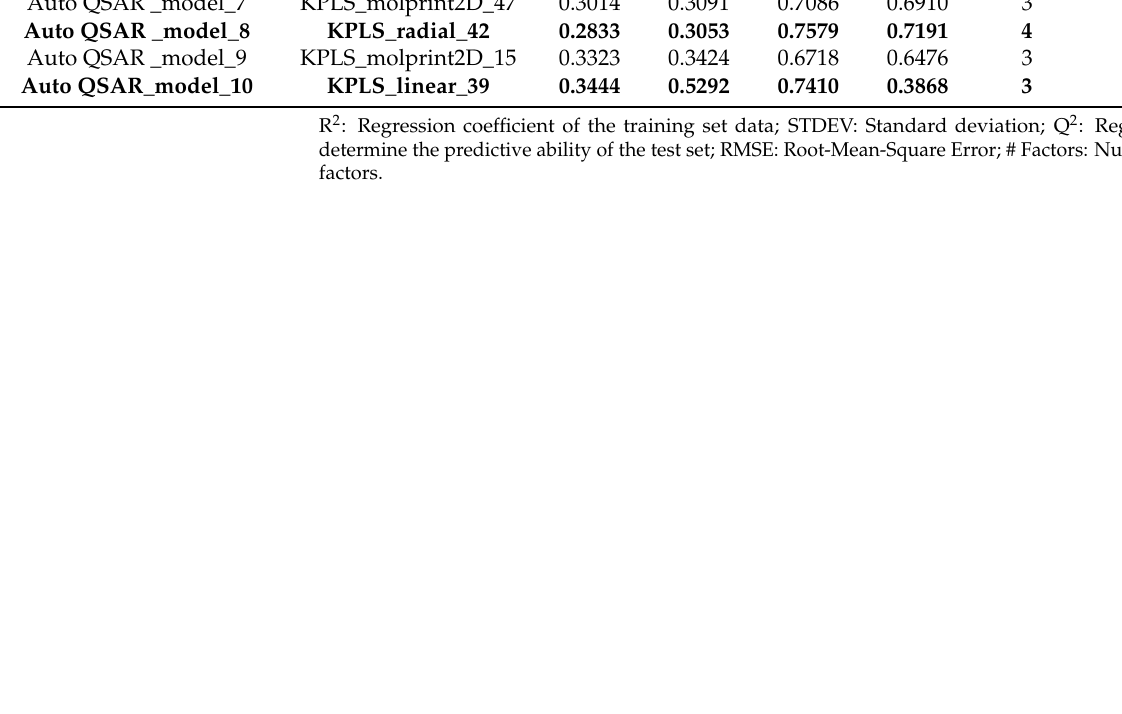
Table 1 details the models built using the subsets of enumerated design ideas, ac- companied by their statistical parameters following an active learning approach. In this approach, all models reported in Table 1 were trained to learn to predict the docking scores of a diverse set of design ideas targeting SARS-CoV-2 PL pro . The models, Auto QSAR _model_1 up to Auto QSAR _model_10, were generated using KPLS, but they differed in terms of binary fingerprints, since the enumerated design ideas have different building blocks attached in place of the naphthalene moiety (Tables 1 and 2). The most significant models with good R 2 > 0.70, Q 2 > 0.64, STDDEV < 0.30, and RMSE < 0.31 were models 6 , 7 , 8, and 10 (Table 1). Hence, models 8 and 10 were selected to predict the binding affinities of the compounds that remained and did not undergo Glide SP docking before all the